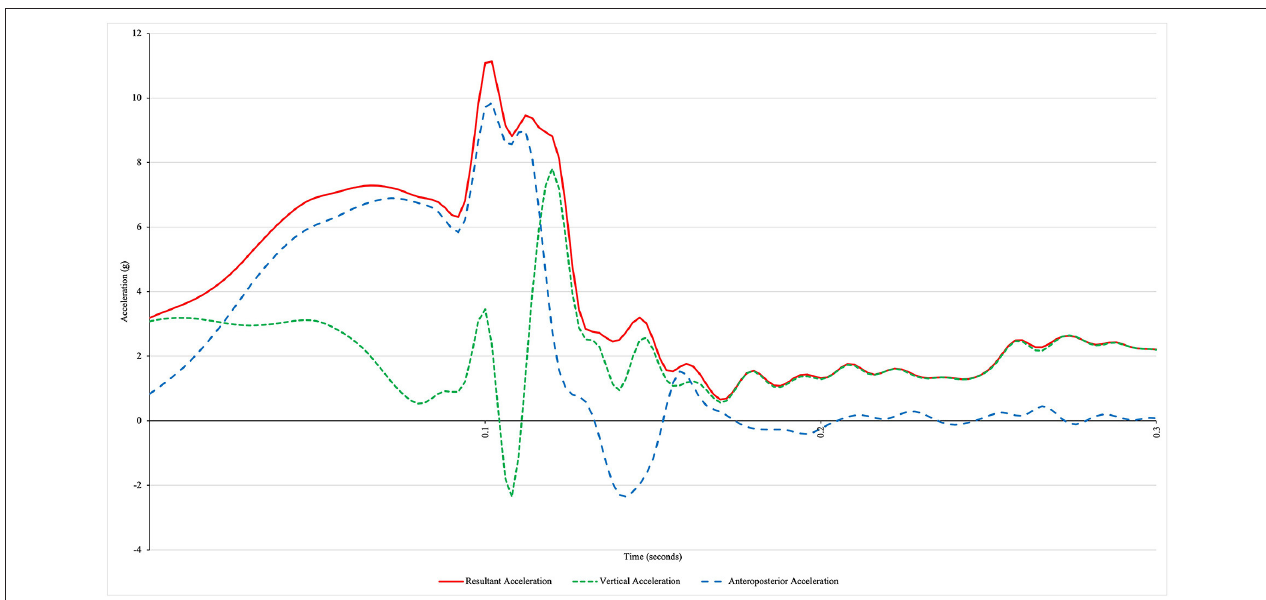
FIGURE 2 | The representative acceleration profile of a rearfoot strike runner using an insole-embedded inertial measurement unit. The x-axis represents the time from initial contact (0s).